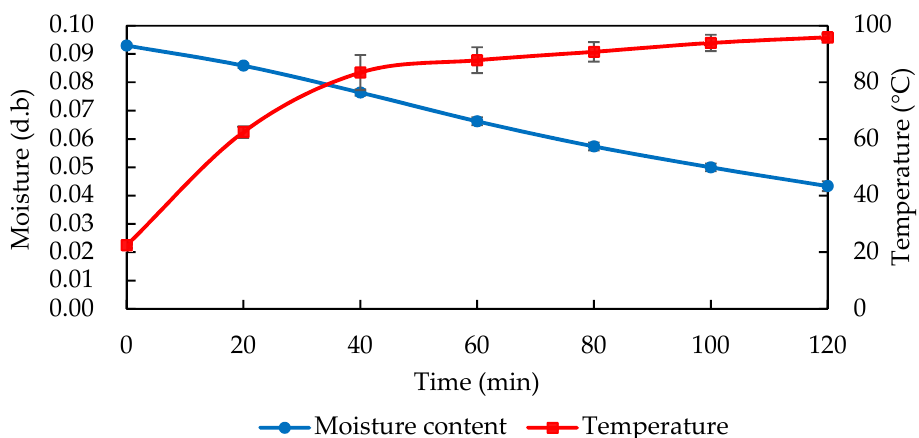
Figure 4. The drying curve and temperature profile of 1 kg almonds during 105 °C oven roasting. Data are expressed as mean ± S.D. ( n = 3).